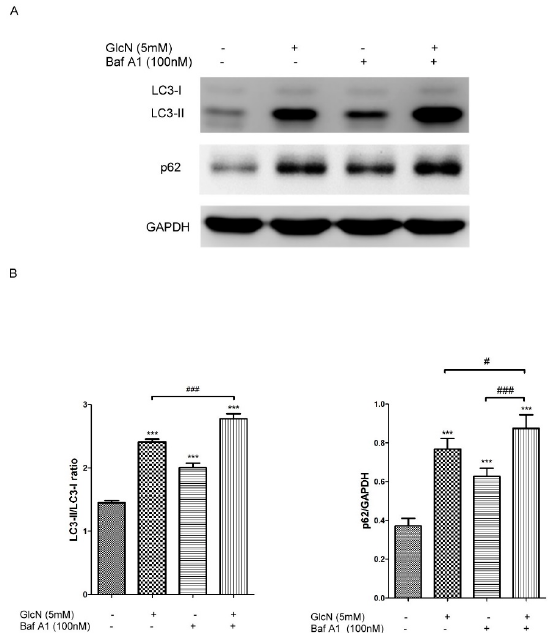
Figure 3. GlcN increases autophagy flux in ARPE-19 cells. ( A ) The cells were pre-treated with or without Bafilomycin A1 (Baf A1; 100 nM) for 1 h followed by co-treatment with or without GlcN (5 mM) for another 18 h. Whole-cell lysates were prepared and analyzed with immunoblotting using anti-LC3, anti-p62, and anti-GAPDH antibodies. ( B ) The optical density of Western blot bands for LC3-I, LC3-II, p62, and GAPDH was analyzed. The results are represented as the mean ± SEM. The differences in the LC3-II/LC3-I ratios and p62/GAPDH in ARPE-19 cells between the groups were compared using ANOVA. Tukey’s test was used for the post hoc analysis; *** p < 0.001 versus the control group; # p < 0.05; ### p <